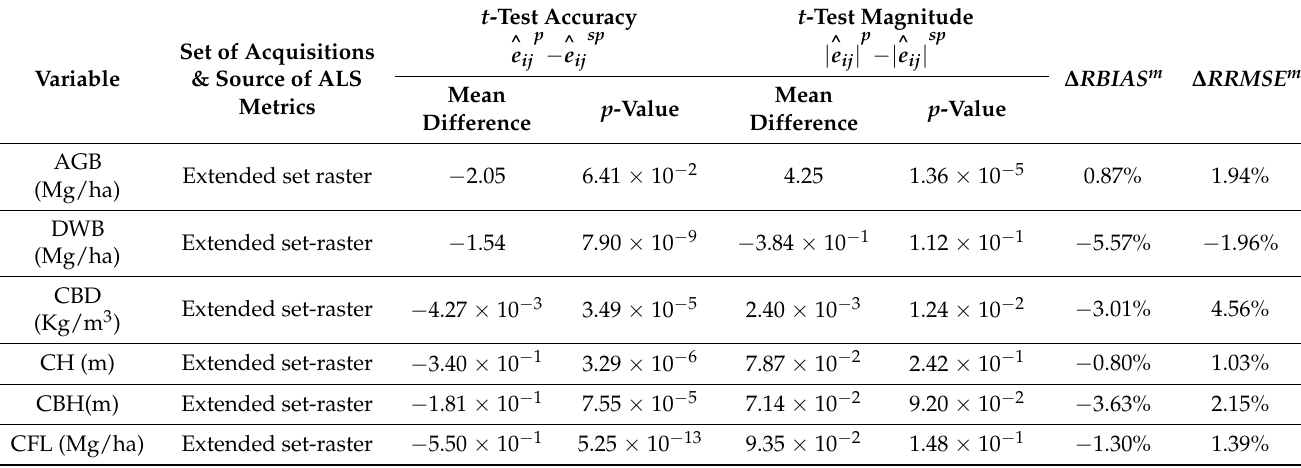
Table A3. Global differences between parametric and semiparametric models in the extended dataset of 20 ALS acquisitions. AGB, DWB, CBD, CH, CBH, and CFL respectively indicate aboveground biomass, downed woody biomass, canopy bulk density, canopy height, canopy base height, and canopy fuel load. Superscripts p and sp indicate error metrics for parametric and semiparametric models respectively and the superscript m denote changes in RBIAS and RRMSE due to using a different modeling